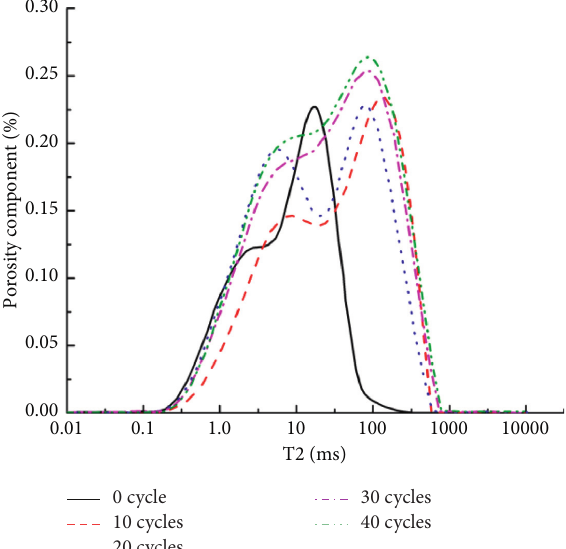
Figure 15: T2 spectrum of sandstone that suffered different F-T cycles [27].